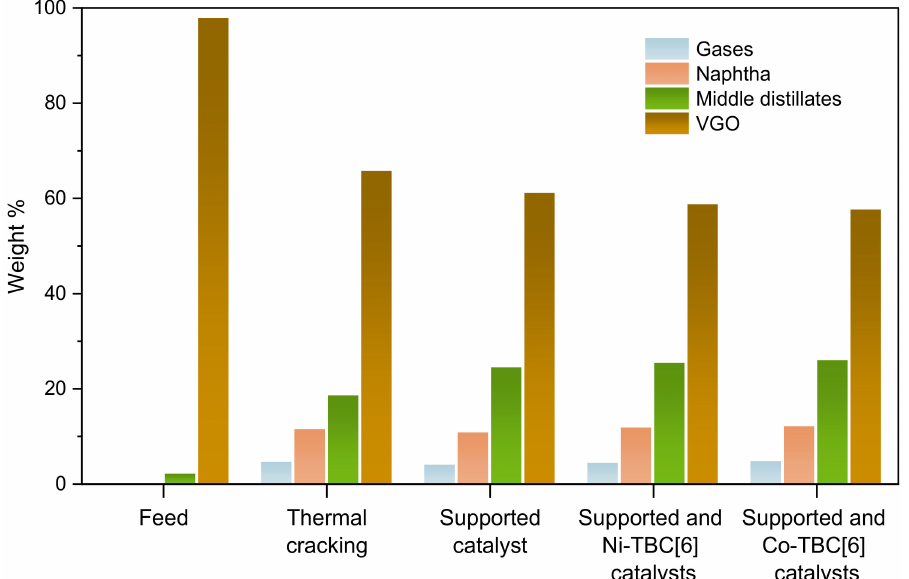
Figure 5. Product yield distribution and conversion of VGO hydrocracking at 420 ◦ C under an H 2 pressure of 8.5 MPa for a reaction time of 1 h for supported and dispersed metal catalysts. The dispersed catalysts metal concentrations for Ni-TBC[6] and Co-TBC[6] catalysts were 500 ppm for each case. Coke yield for all cases was